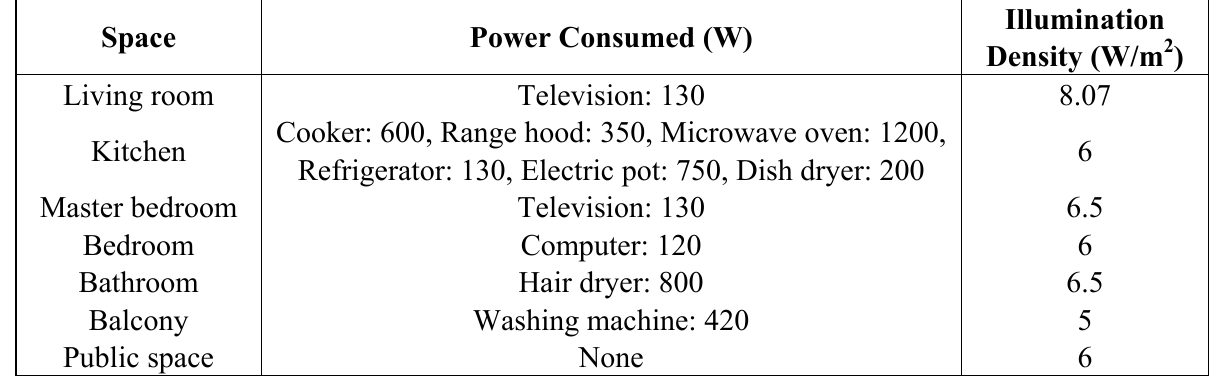
Table 3. Electricity consumption values assumed for household